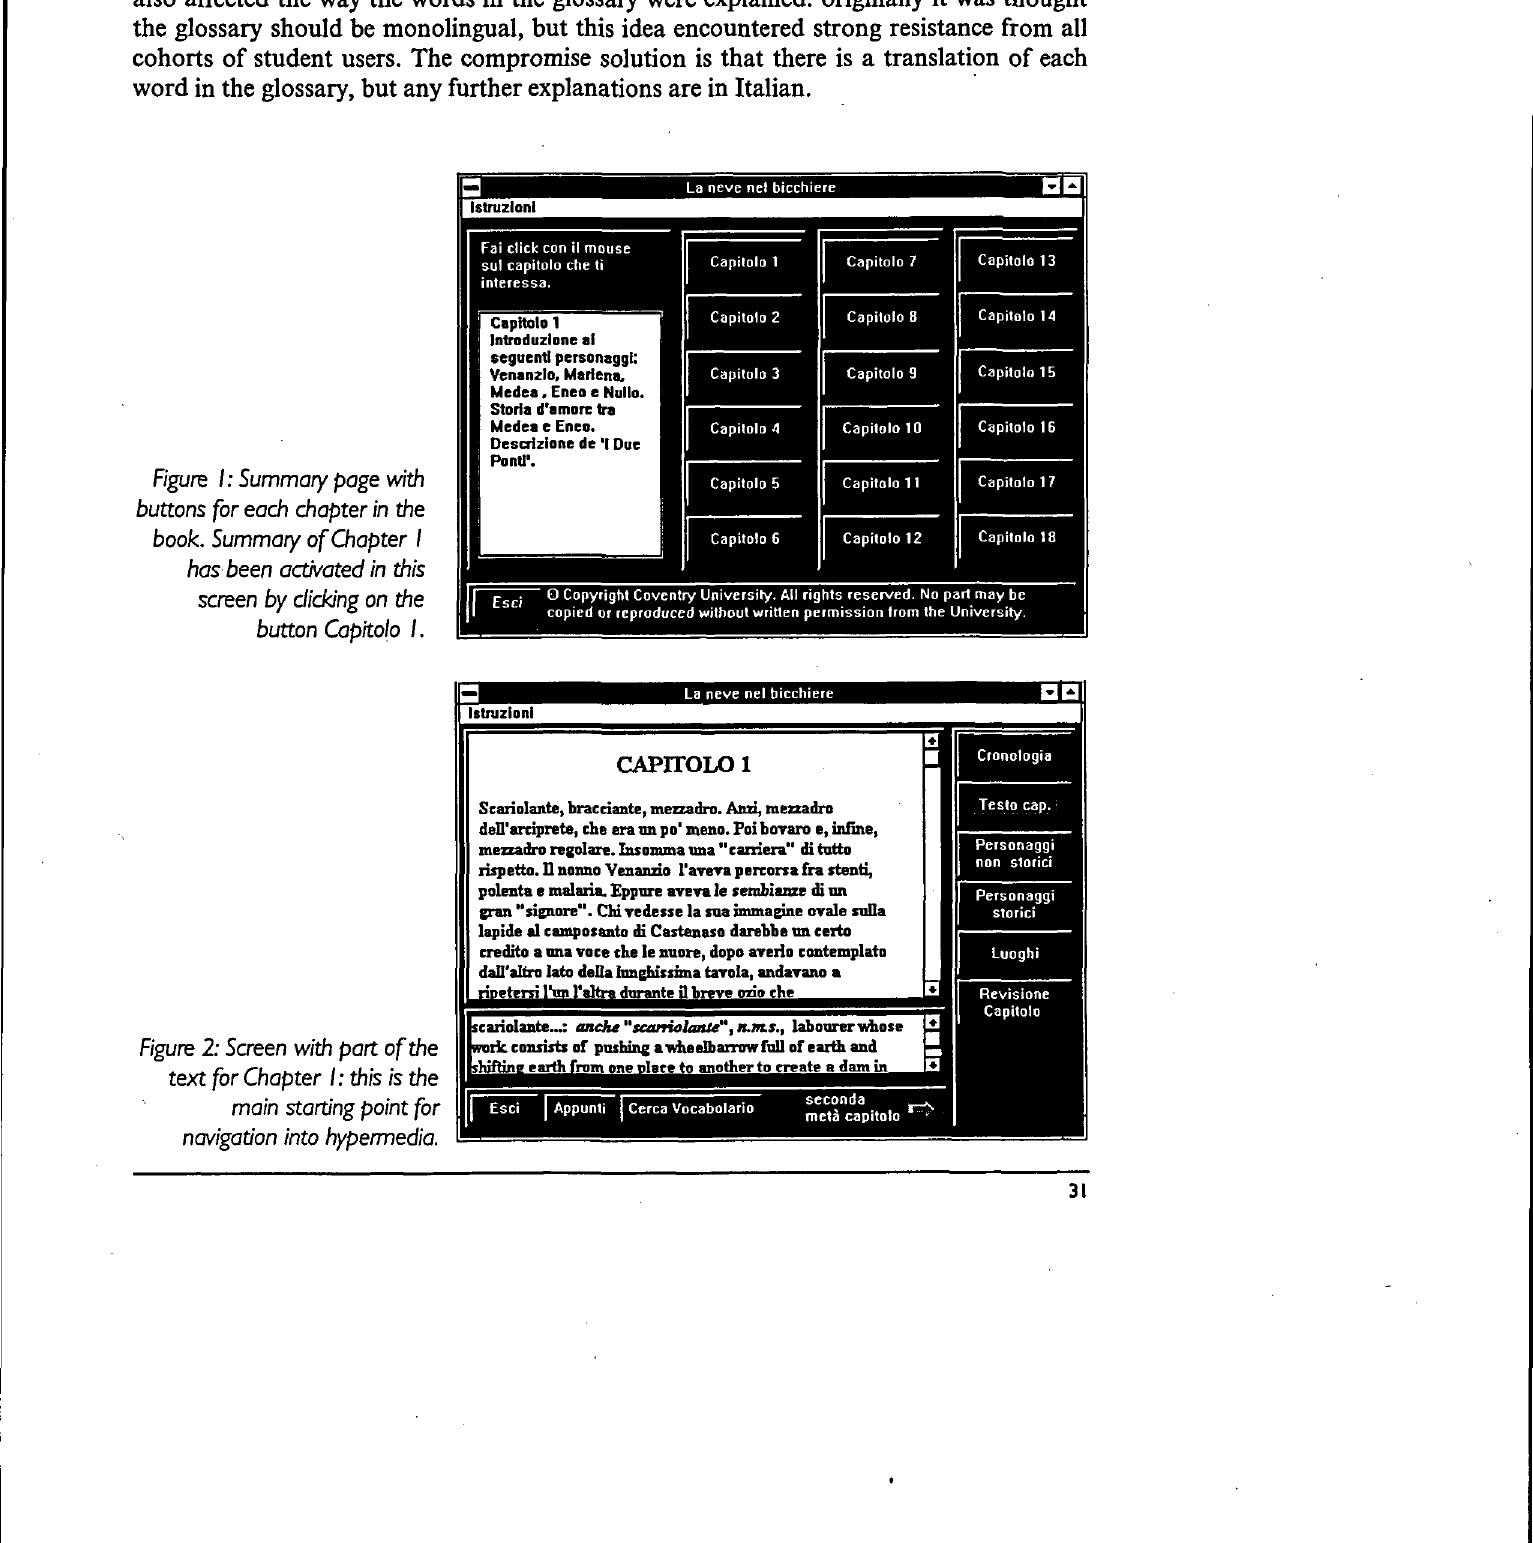
Figure I: Summary page with buttons for each chapter in the book. Summary of Chapter I has been activated in this screen by clicking on the button Capitolo I.